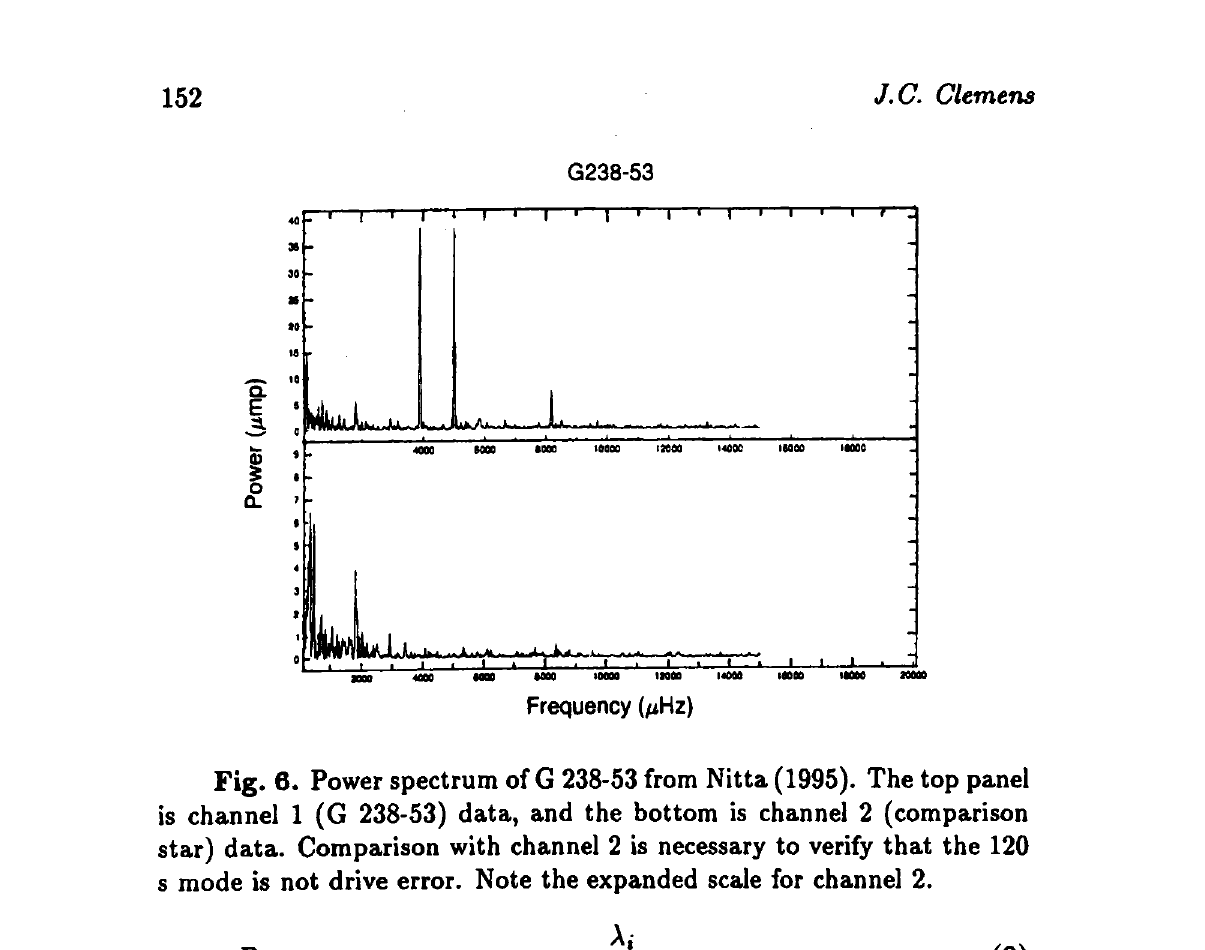
Fig. 6. Power spectrum of G 238-53 from Nitta (1995). The top panel is channel 1 (G 238-53) data, and the bottom is channel 2 (comparison star) data. Comparison with channel 2 is necessary to verify that the 120 s mode is not drive error. Note the expanded scale for channel